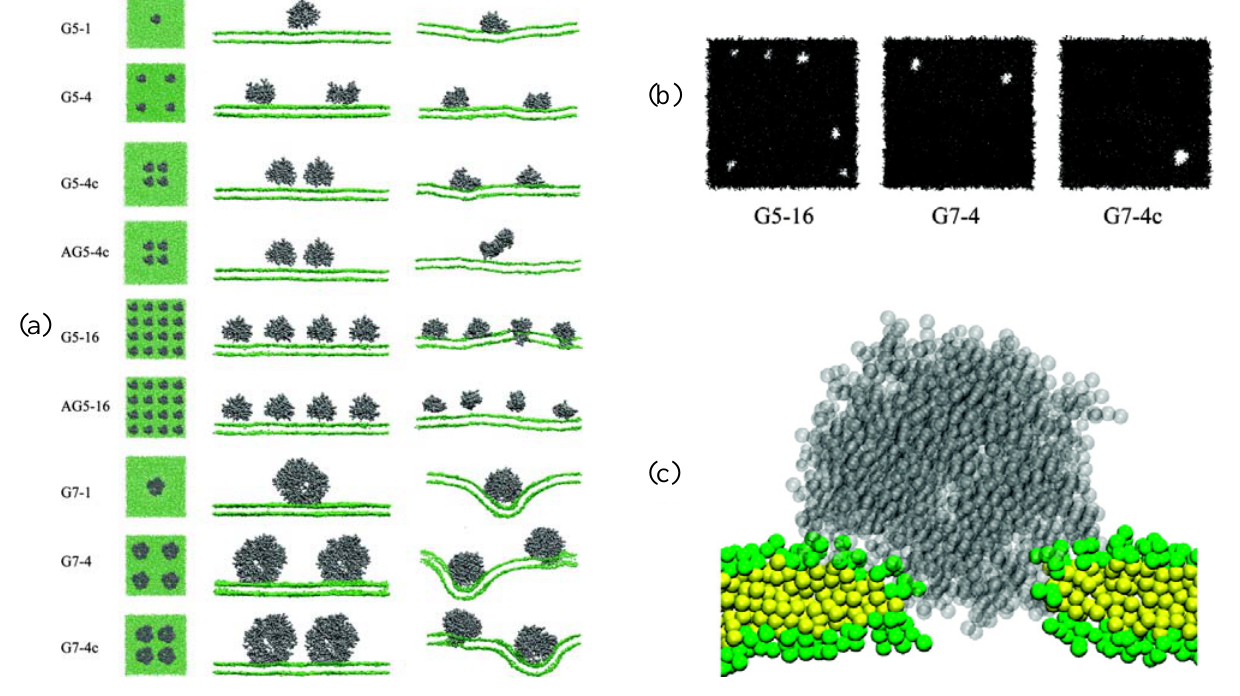
Figure 4 . (a) Snapshots of the top view (left image) and the side view (middle image) at the beginning (0 ns) and the side view at the end (240 ns, right image) of simulations of multiple CG dendrimers with a DMPC bilayers. Gray dots represent dendrimers, and green dots represent headgroups of the DMPC bilayer. The explicit water molecules, DMPC tails, and ions are omitted for clarity. Note that side views show only one cross section of the system and cannot capture all dendrimers. (b) Top view of the DMPC bilayer at the end (240 ns) of simulations G5-16, G7-4, and G7-4c. (c) A snapshot of the dendrimer-induced pore in a DMPC bilayer at the end (240 ns) of the simulation G7-4c. Transparent gray dots represent a G7 dendrimer. Green and yellow dots represent head and tail groups of DMPC, respectively. Reprinted with permission from [31]. Copyright 2008 American Chemical